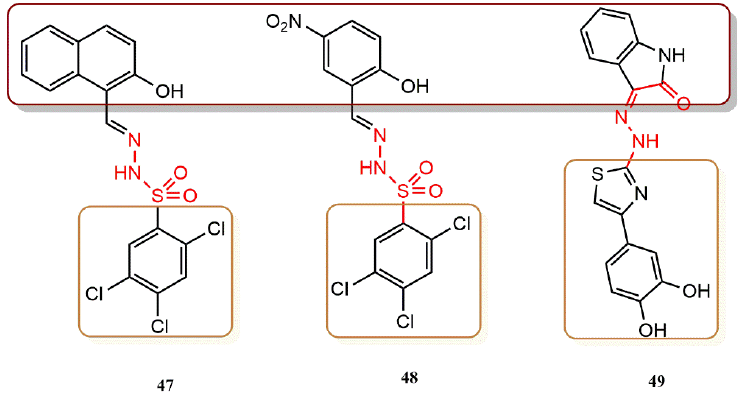
Figure 33. Dual RT pharmacophores of new active synthesized compounds 47 , 48 and 49 .